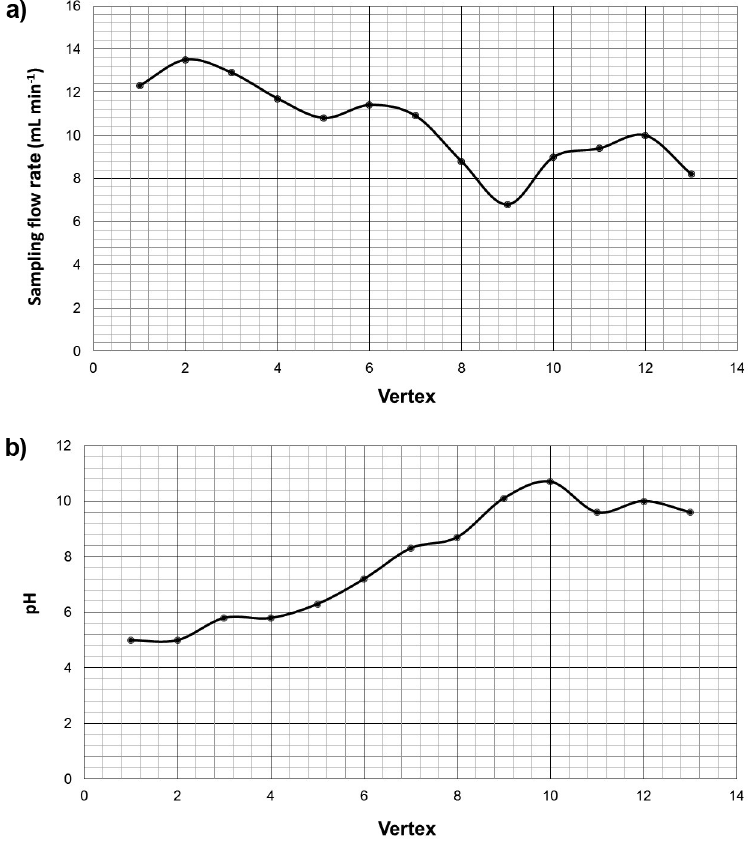
Figure 3 - Evolution of the variables values with the displacement of the triangle de fi ned by the simplex method. ( a ) sampling fl ow rate, ( b )